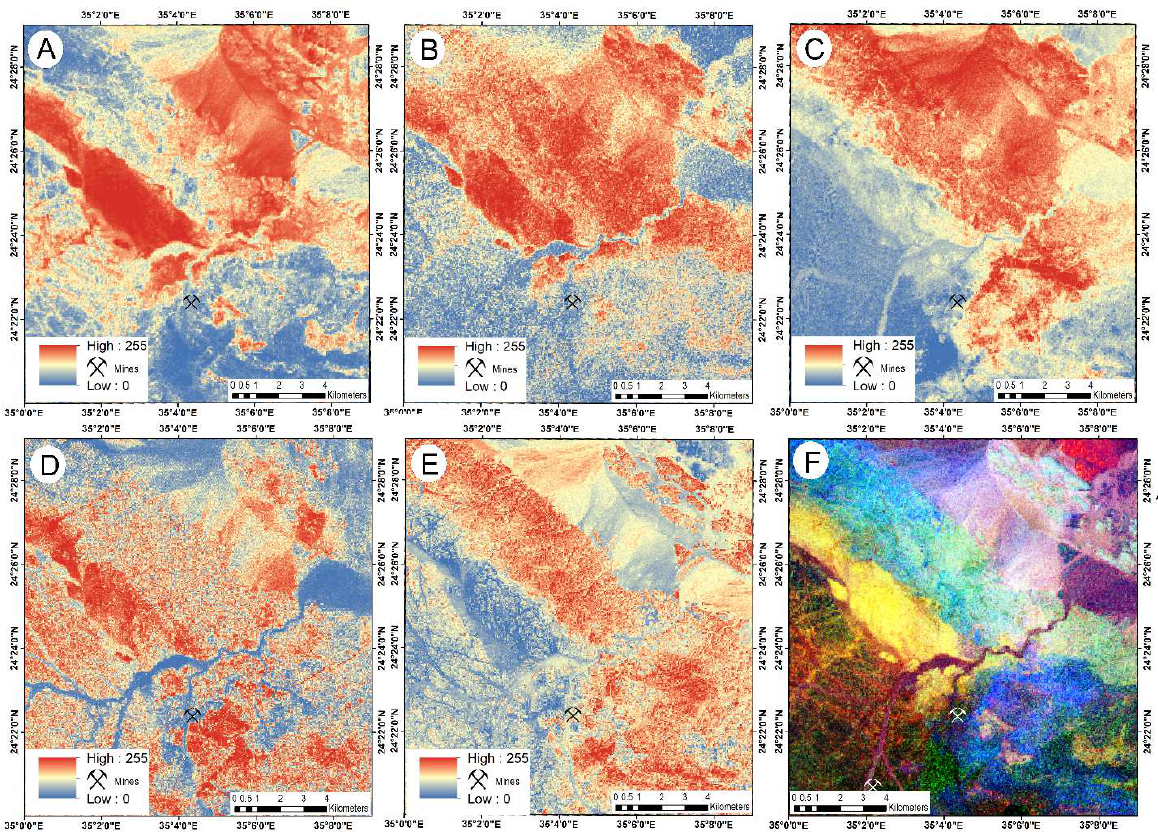
Figure 10. ASTER image processing using band ratio: ( A ) Argillic alteration mapping using band 4/6. ( B ) Phyllic alteration mapping using band ratio 5/6. ( C ) Propylitic alteration mapping using band ratio 5/8. ( D ) Ferric iron alteration mapping using band ratio 2/1. ( E ) Ferrous iron alteration using band ratio 5/3 + 1/2. ( F ) Band-ratio false-color composite for ratio imagery 4/6, 5/6, and 5/8.